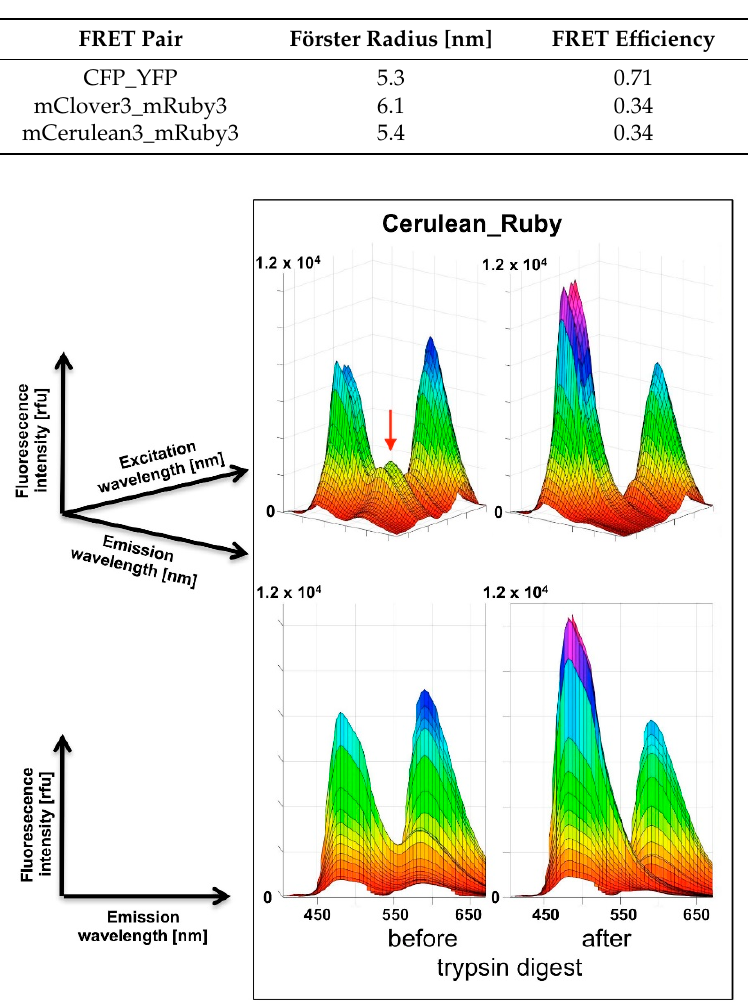
Figure 3. 3D fluorescence spectra of the mCerulean3_mRuby3 fusion construct before and after trypsin digest. In the upper panel, the viewing angle is chosen to support the visualization of the FRET signal (red arrow) that disappears after trypsin digest, while the two-dimensional perspective in the lower panel allows the quantitative comparison of the mCerulean3 and the mRuby3 signal intensities. The mCerulean3 peak height has increased after trypsin digest, due to dequenching, while the mRuby3 peak height has moderately